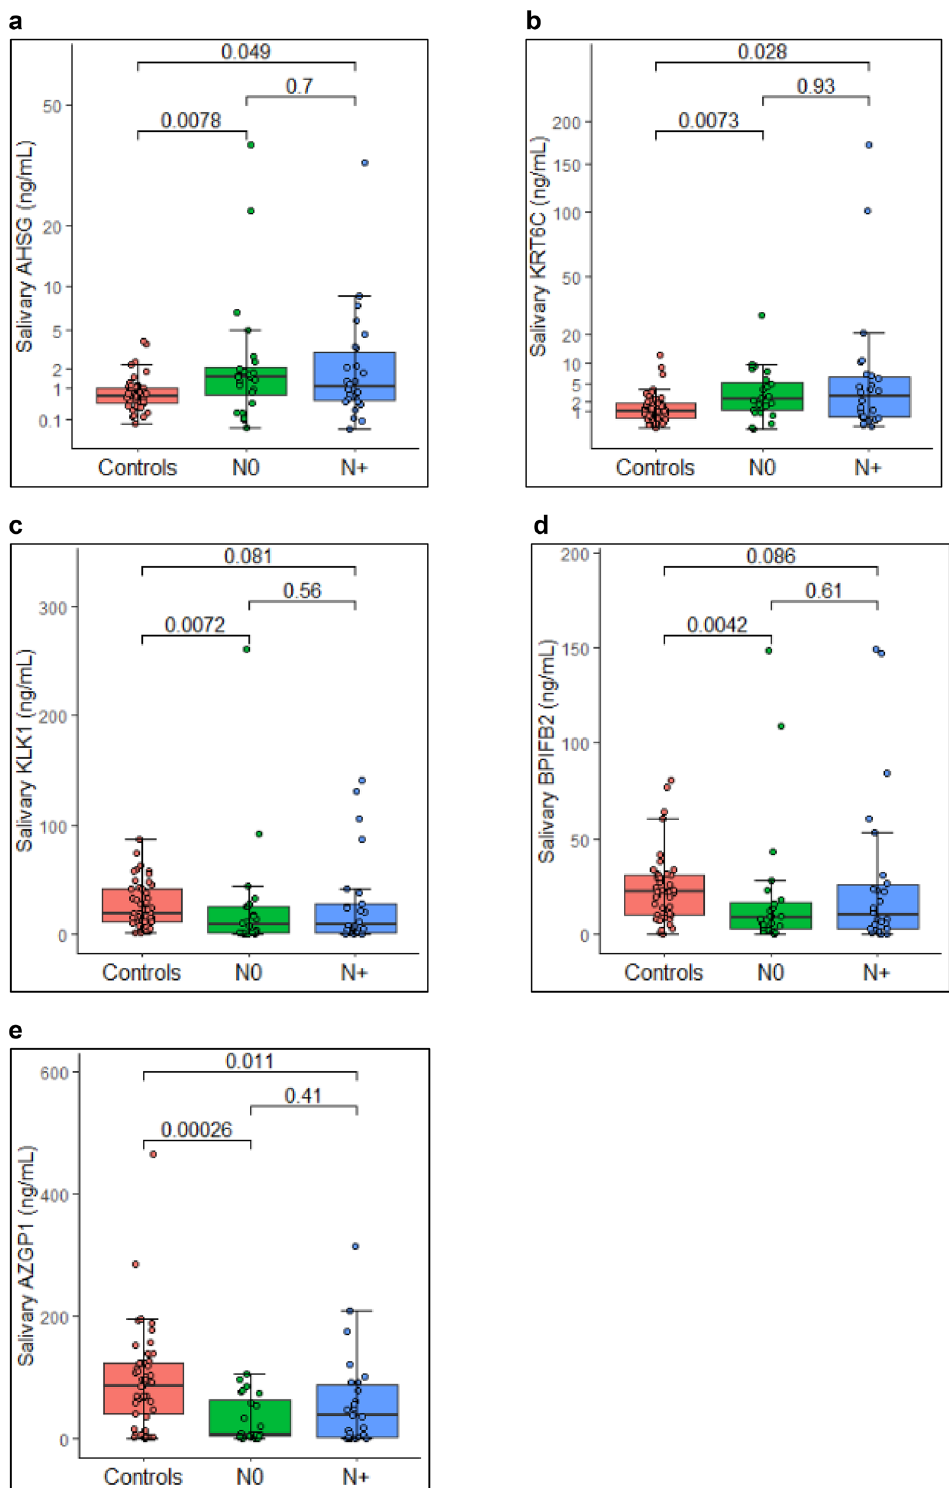
Figure 3. Levels of significantly dysregulated proteins as per regional lymph node metastasis. Boxplot representing the levels of significantly dysregulated proteins amongst healthy controls (n = 49), N0 stage OSCC (n = 24) and N+ (n = 26) stage OSCC cases (Each dot represents individual value). Proteins ( a ) AHSG and ( b ) KRT6C were significantly upregulated in late stage cases. Proteins ( c ) KLK1 and ( d ) BPIFB2 were downregulated in both the stages while ( e ) AZGP1 was significantly downregulated in early stage cases. Wilcoxon sum rank test was used to compare the median protein levels of controls and cases (p < 0.5 was the cut off for statistical